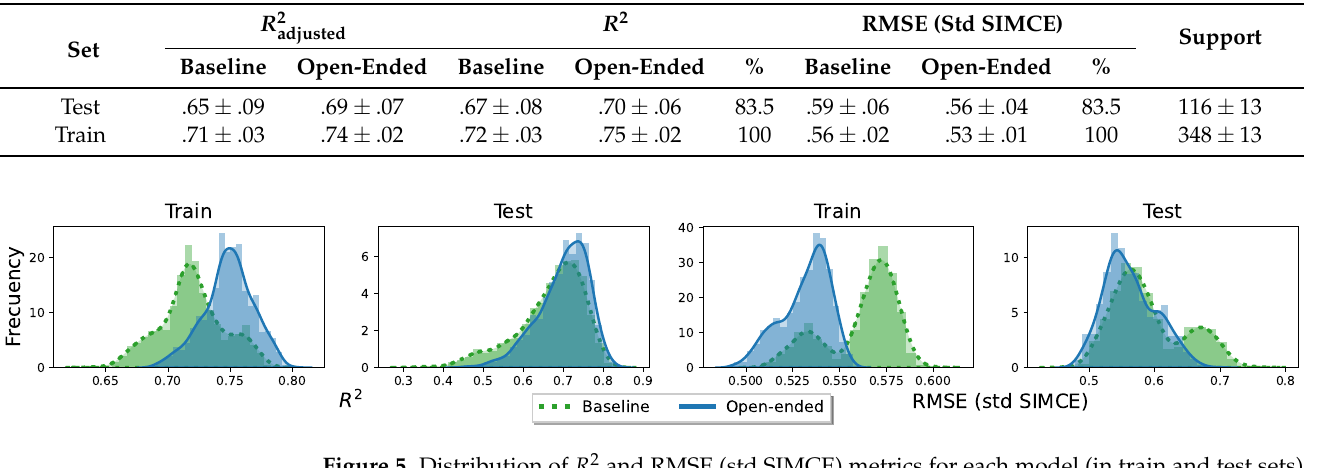
Figure 5. Distribution of R 2 and RMSE (std SIMCE) metrics for each model (in train and test sets). These are obtained from 250 four-fold cross-validations. (Green/dotted) Baseline model. (Blue/line) Open-ended